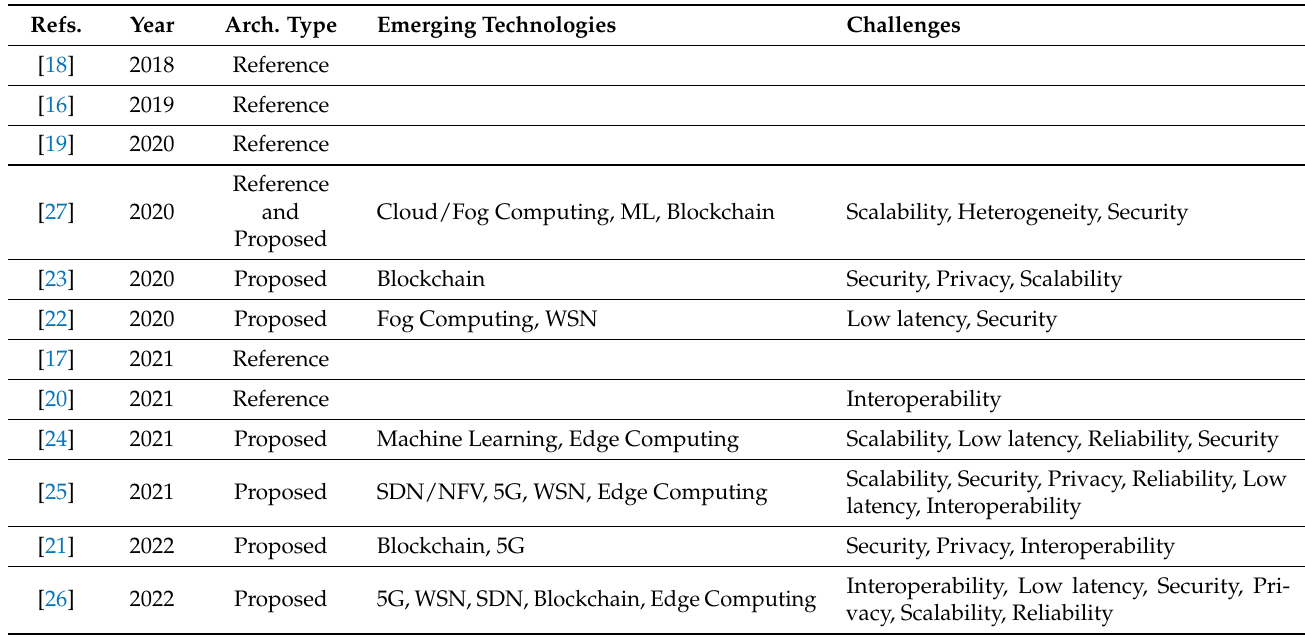
Table 1. Related IIoT architectural review and survey papers and their main topics.